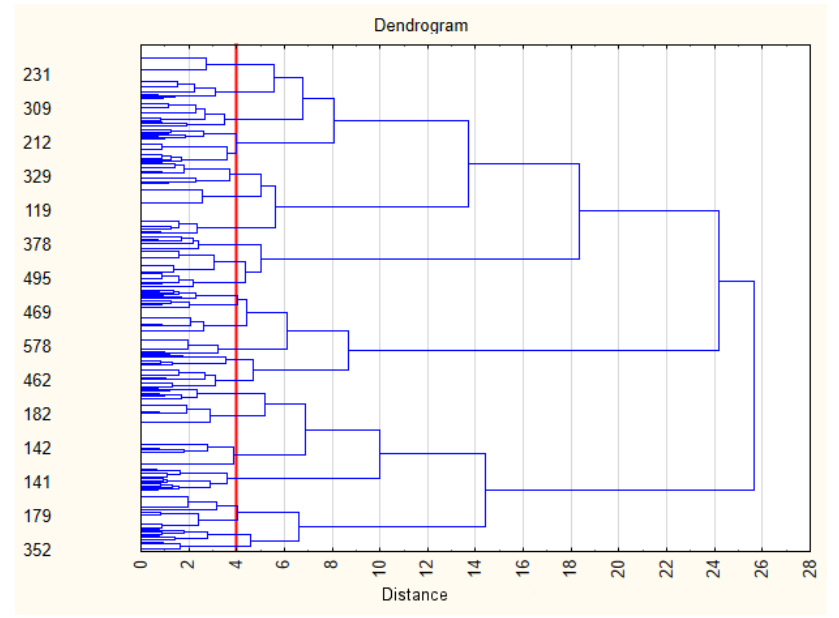
Figure 3. Dendrogram. Source: own elaboration.